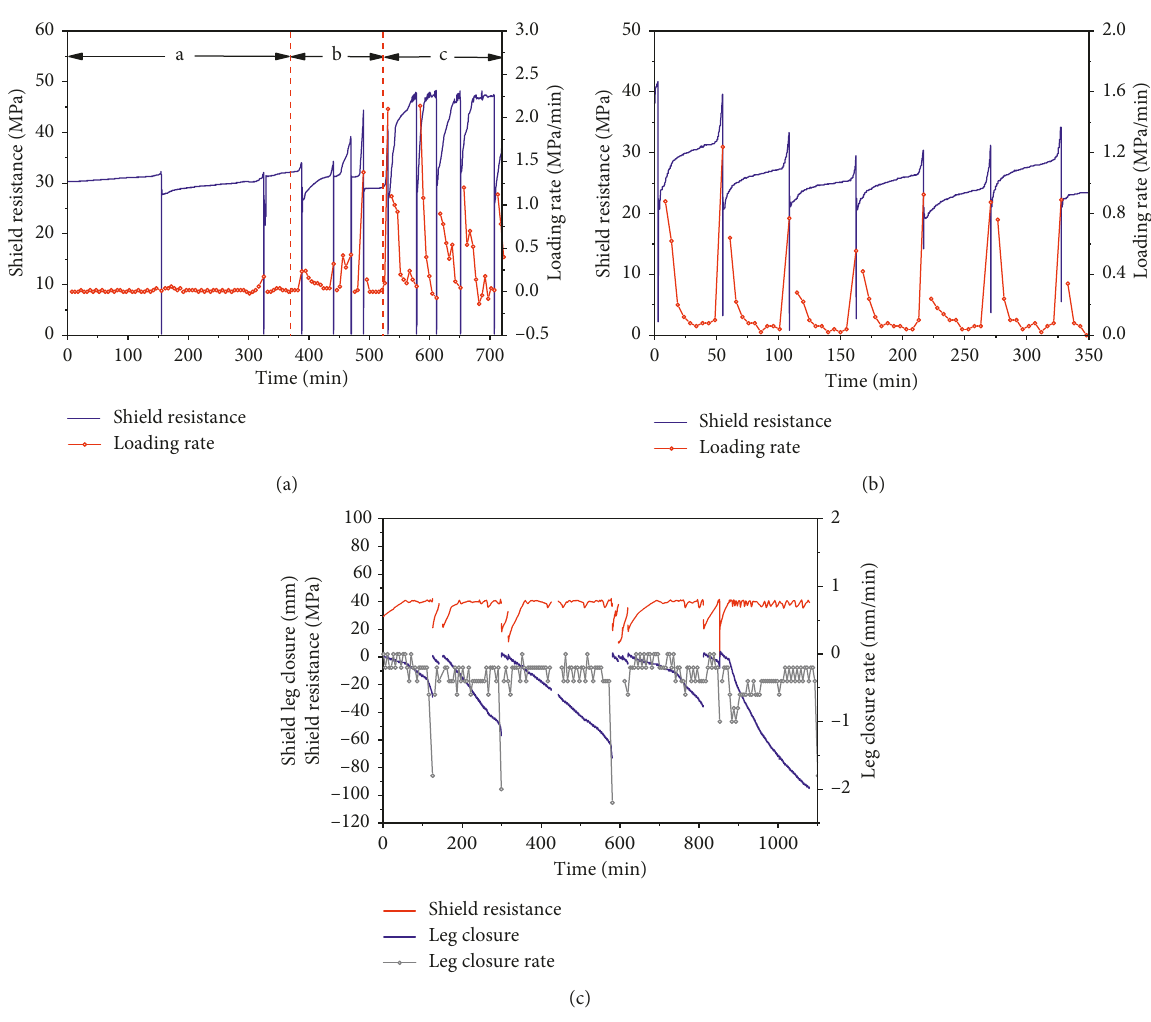
Figure 13: Temporal evolution of shield resistance and loading rate under strong roof (a) and medium-weak roof (b) with adequate shield capacity, as well as shield resistance, loading rate, leg closure, and leg closure rate under medium-weak with inadequate shield capacity (c).